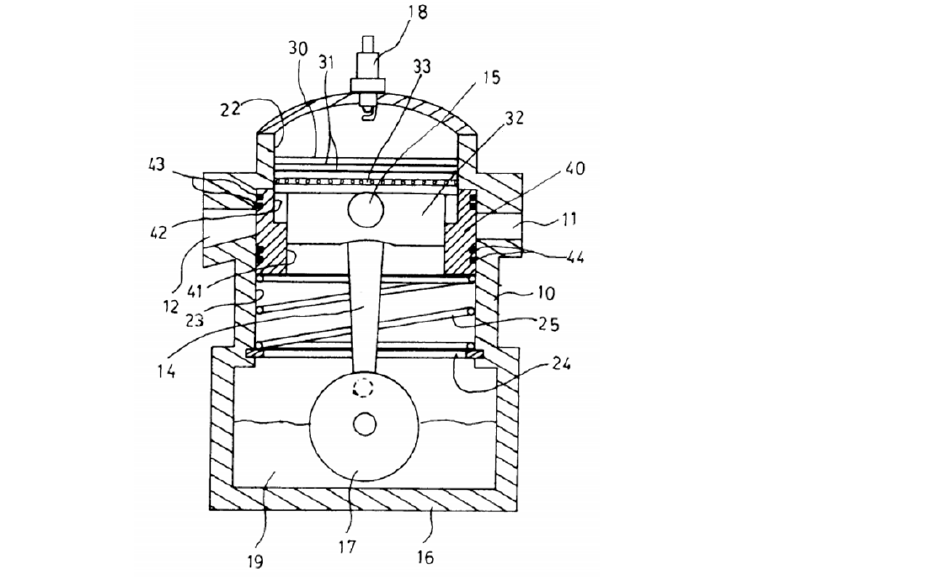
Figure 19. Y. Chen 6 November 2003, two-stroke engine US 6662764B2. Reproduced with permission from US Patent Office. Copyright Publisher, 2003.